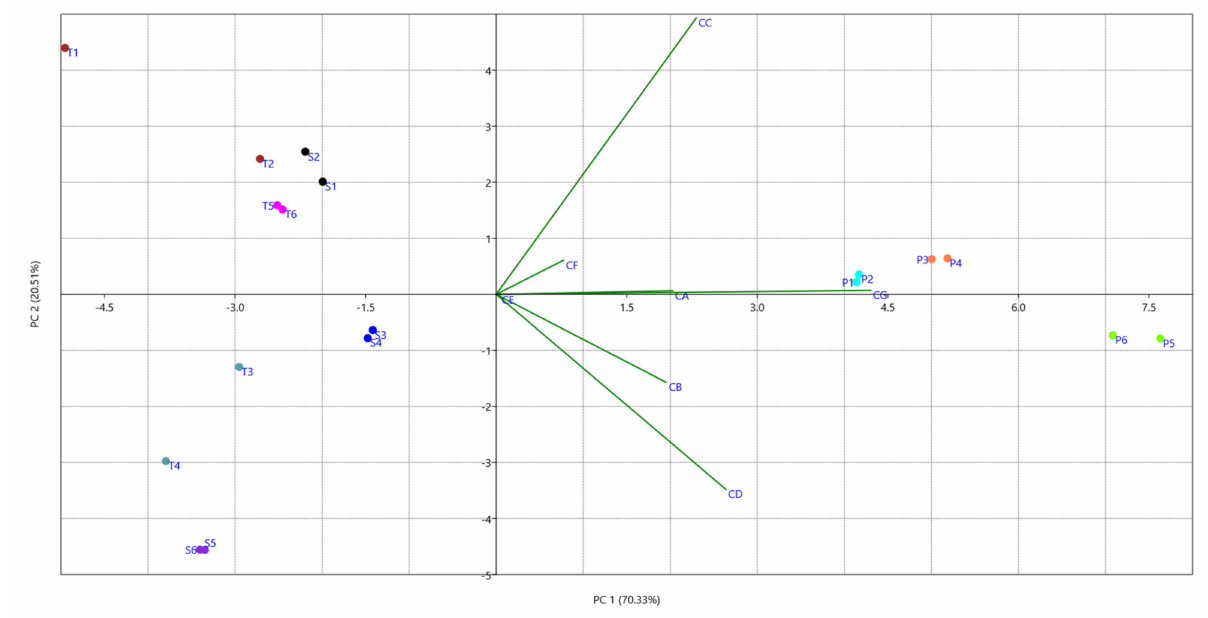
Figure 9. PCA biplot showing the variance between the M. whitei